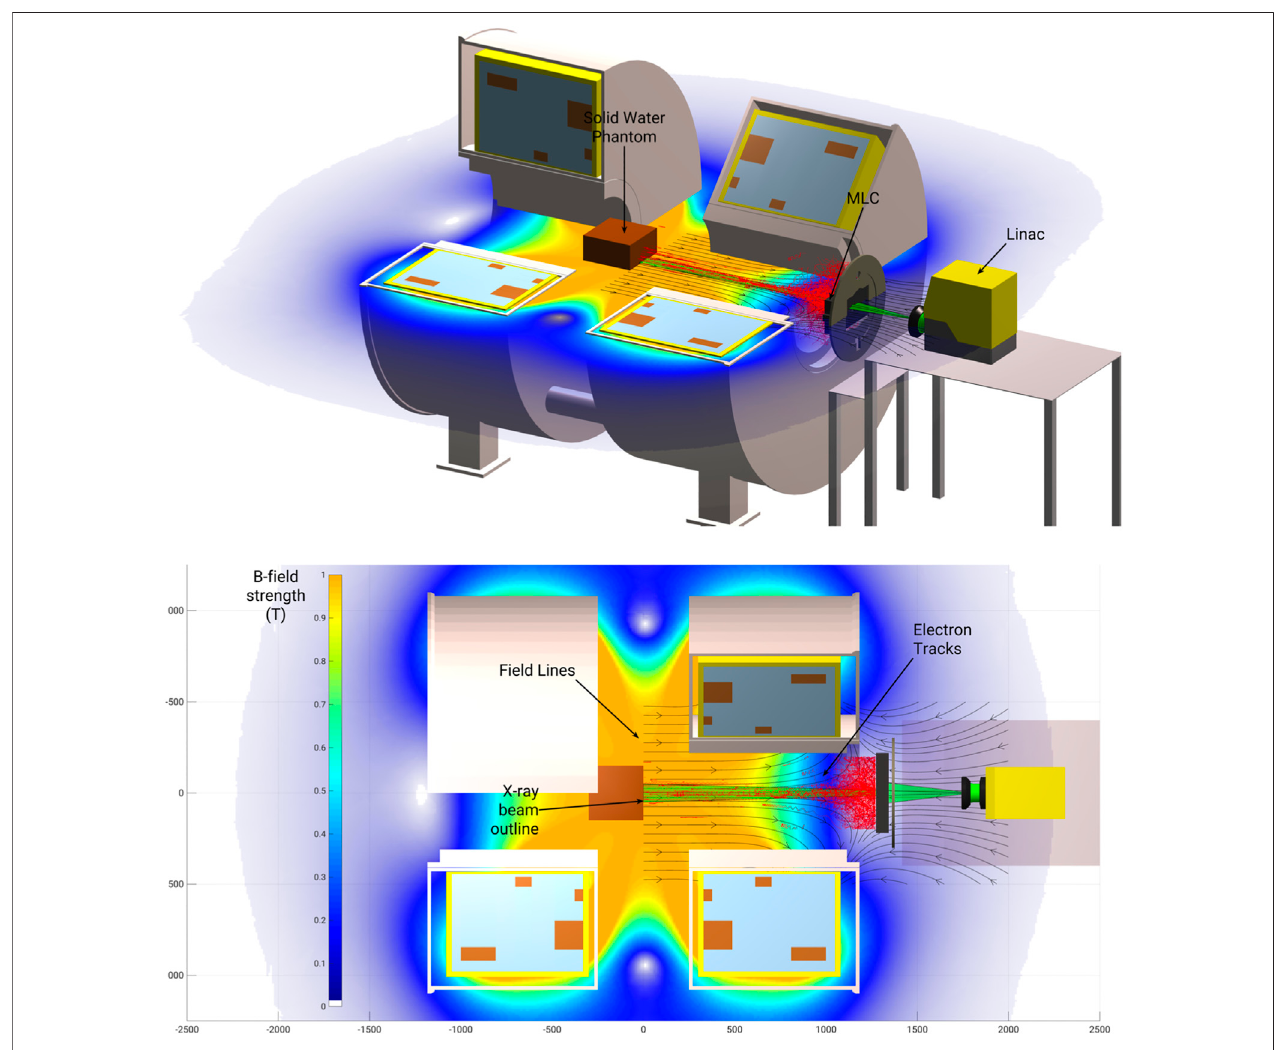
FIGURE 1 | Schematic diagram of the Sydney MRI-Linac system at the Ingham Institute.